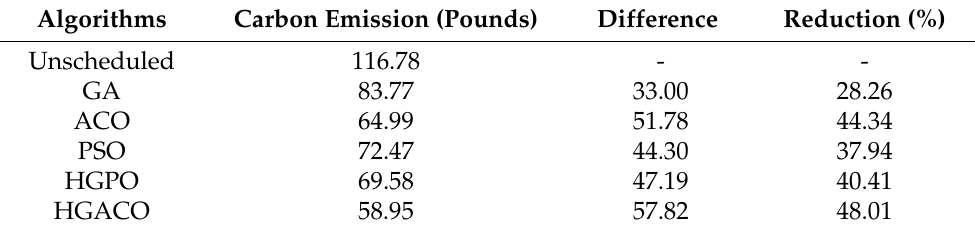
Figure 12. Scenario I: Carbon emission assessment without photovoltaic-battery systems. Table 8. Scenario I: Carbon emission assessment without photovoltaic-battery